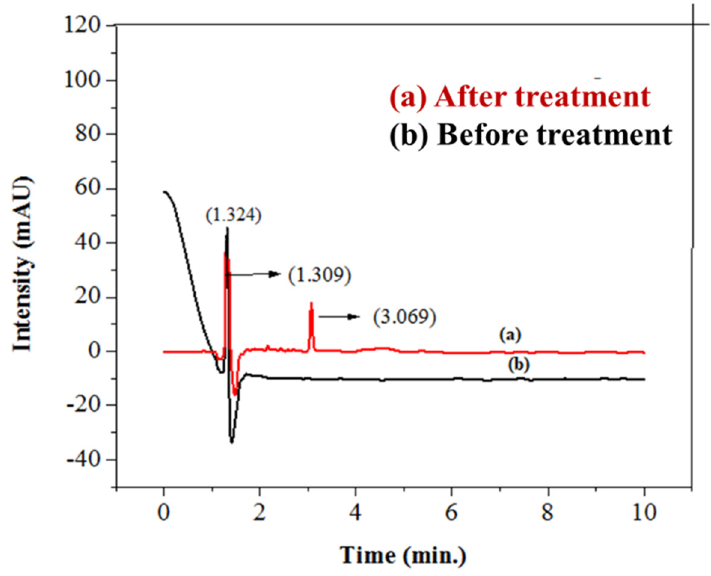
Figure 12. HPLC chromatogram of ( a ) sample of imidacloprid treated with basic prewetted nanocal- cite @ PF (pH 11) and ( b ) untreated imidacloprid sample.